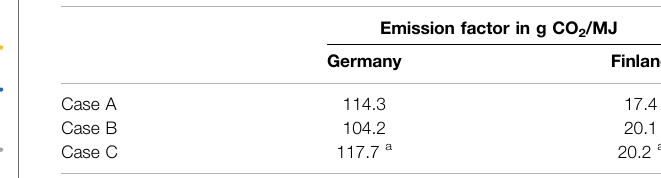
TABLE 5 | Calculated emission factors for produced